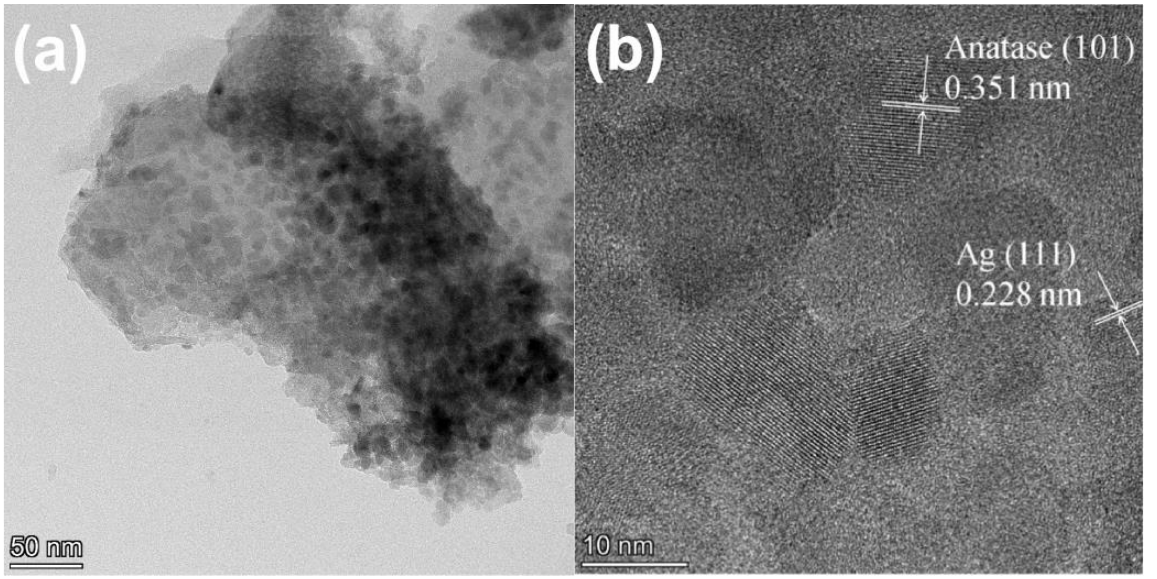
Figure 3. TEM ( a ) and HRTEM ( b ) images of 1-ATM.